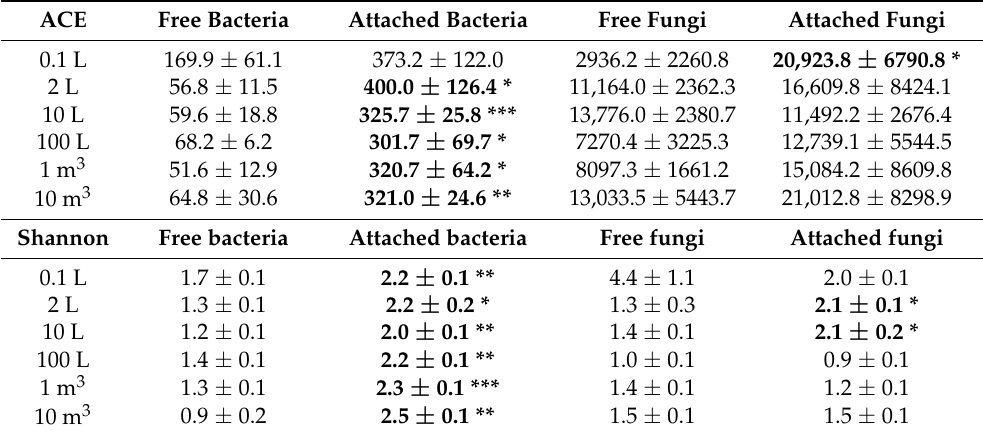
Table 4. Comparisons of α -diversity indices (ACE and Shannon index) between the free and attached microbial communities.